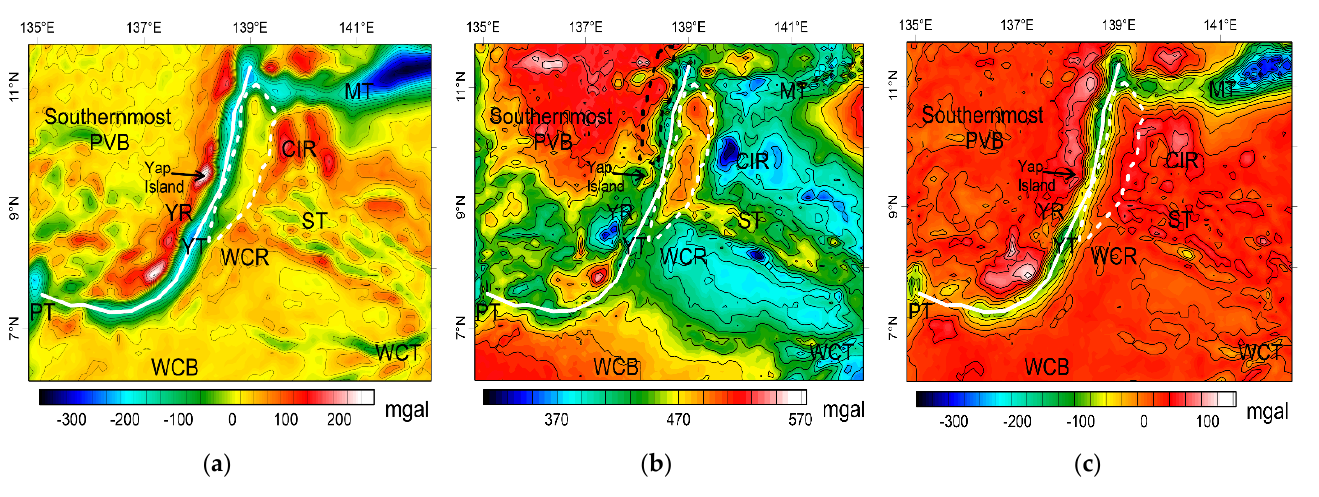
Figure 8. Gravity anomaly fields of the YSZ. ( a ) Free-air gravity anomaly; ( b ) Bouguer gravity anomaly; ( c ) Isostatic gravity anomaly. The contour interval for both maps is 5 mGal. The white dashed polygon delineates the area of horsts and grabens. The J-shaped solid white line delineates the Yap Trench axis. The black dashed polygon delineates the region of the Yap arc with unusually higher Bouguer anomalies. See Figure 1 for abbreviations.